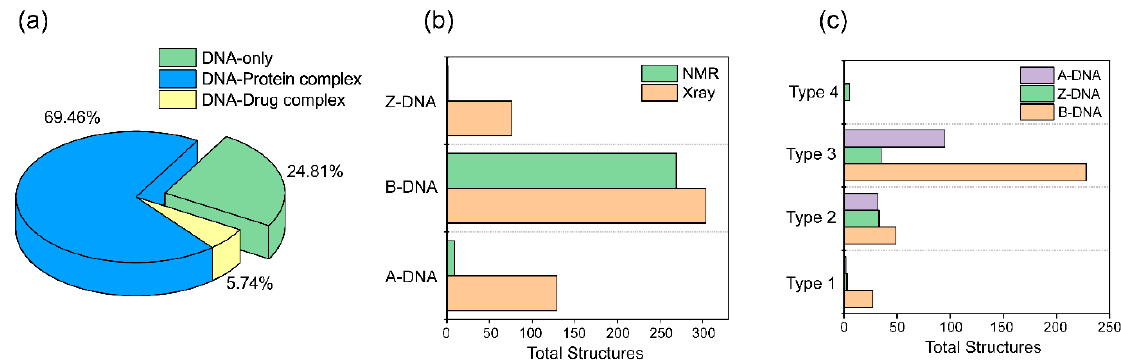
Figure 1. DNA crystal structures and their packing interactions. ( a ) Distribution of the reported DNA crystal structures deposited in the Nucleic Acid Database (NDB). DNA structures are classified by the binding partners; no ligand (DNA-only), protein, and drug, ( b ) DNA-only crystal structures in NDB are analyzed based on their conformations and methods for structure determination. ( c ) DNA-only crystal structures are analyzed based on their packing types and conformations.